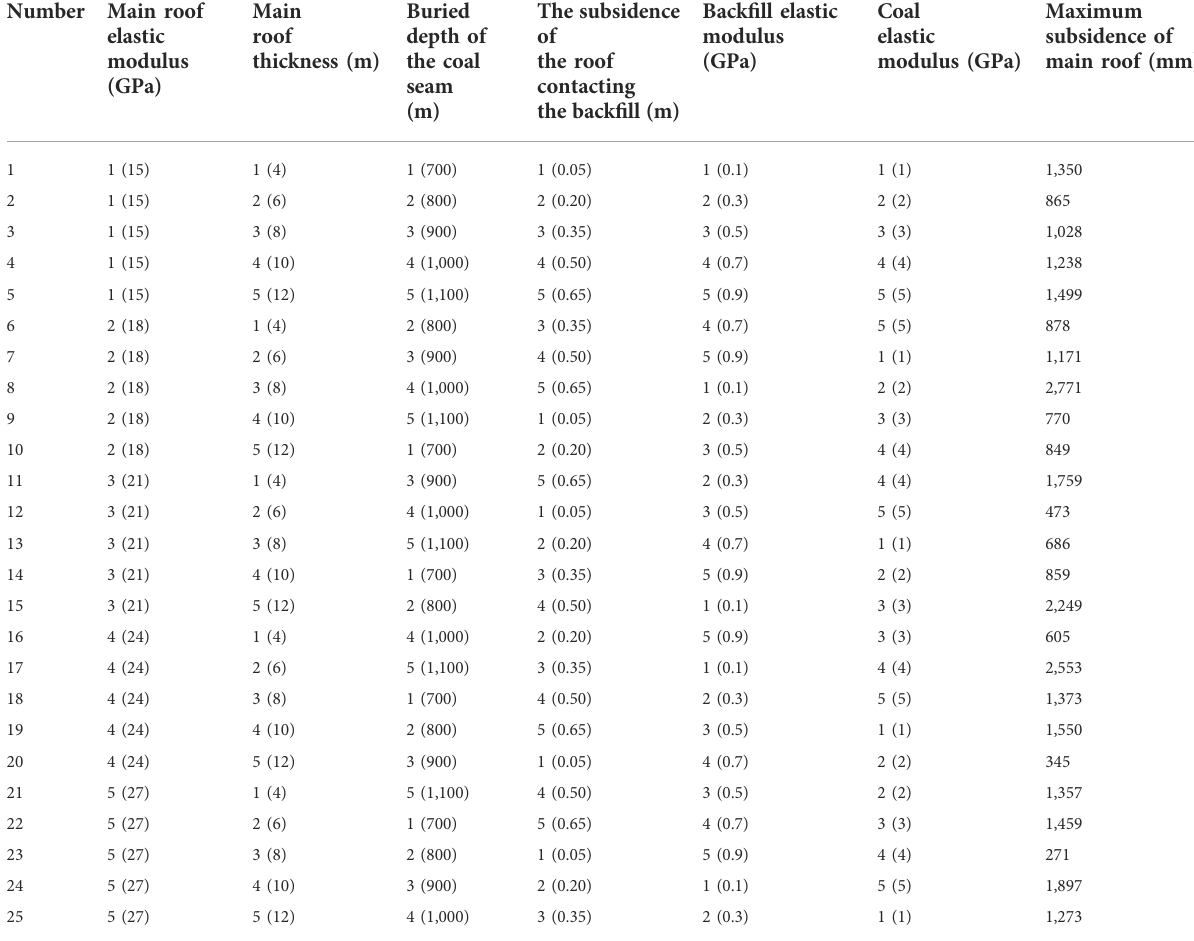
TABLE 6 Orthogonal experiment table of various in fl uencing factors.